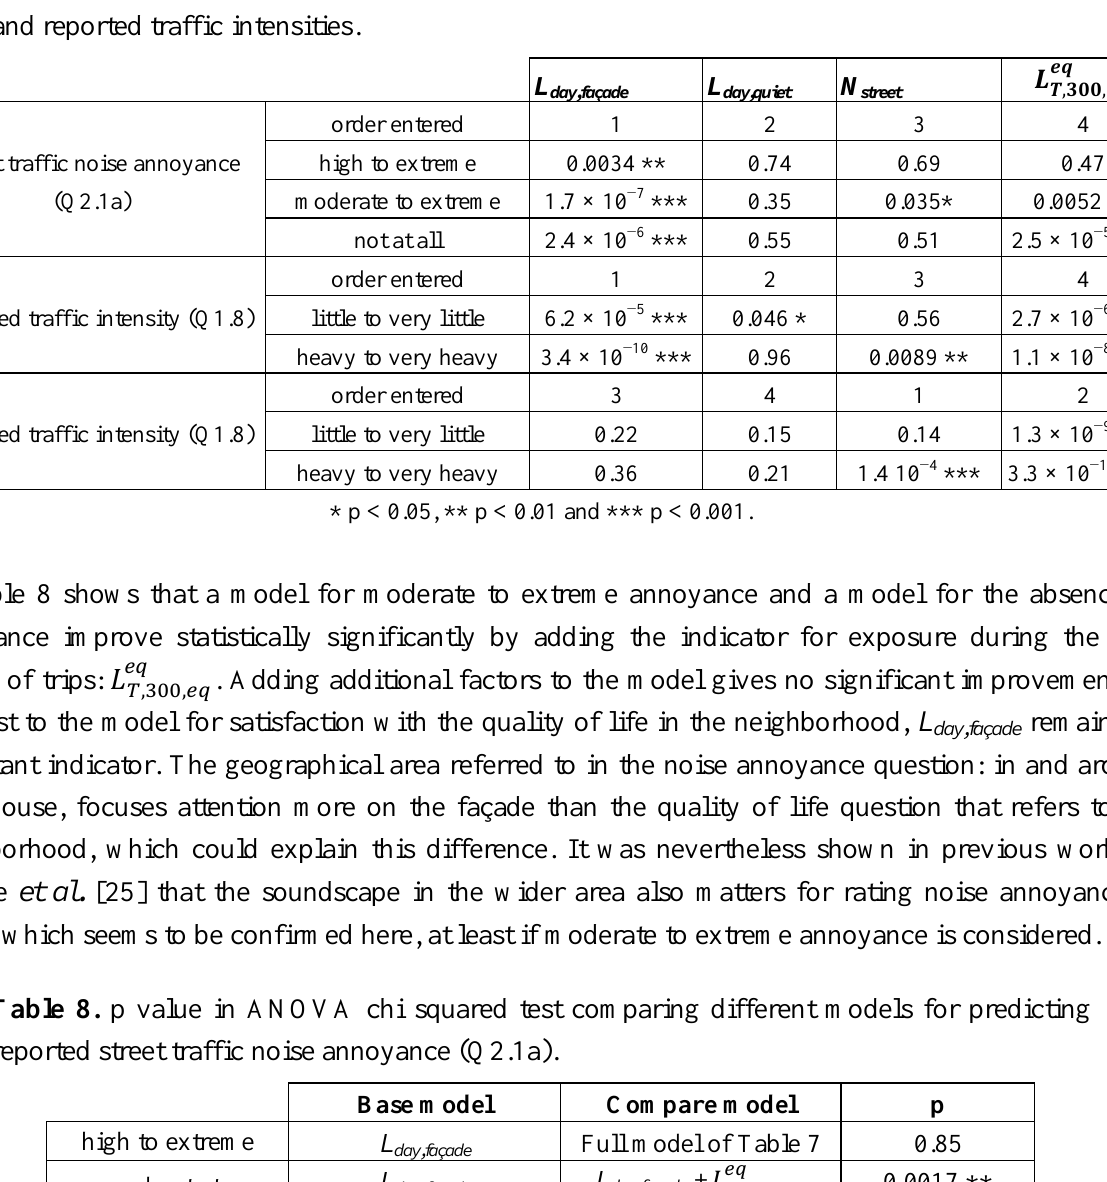
Table 7. p in chi squared test for logistic model predicting street traffic noise annoyance and reported traffic intensities.